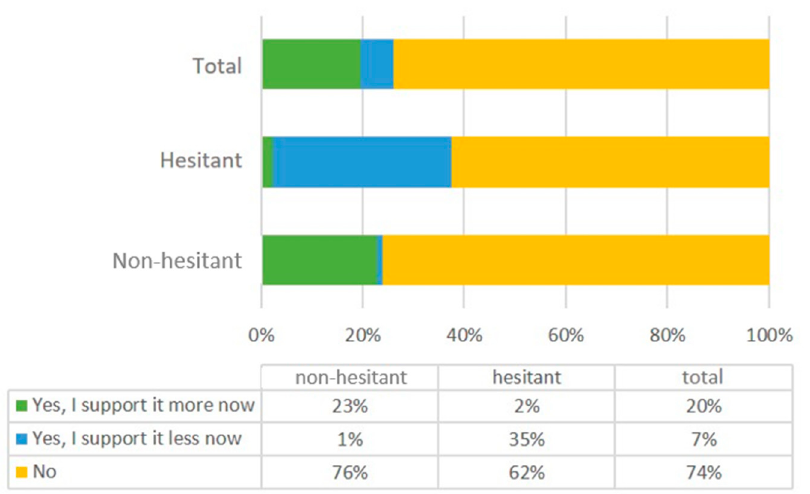
Figure 2. Participant responses to the question “Has the pandemic changed your attitude towards compulsory vaccination?”.